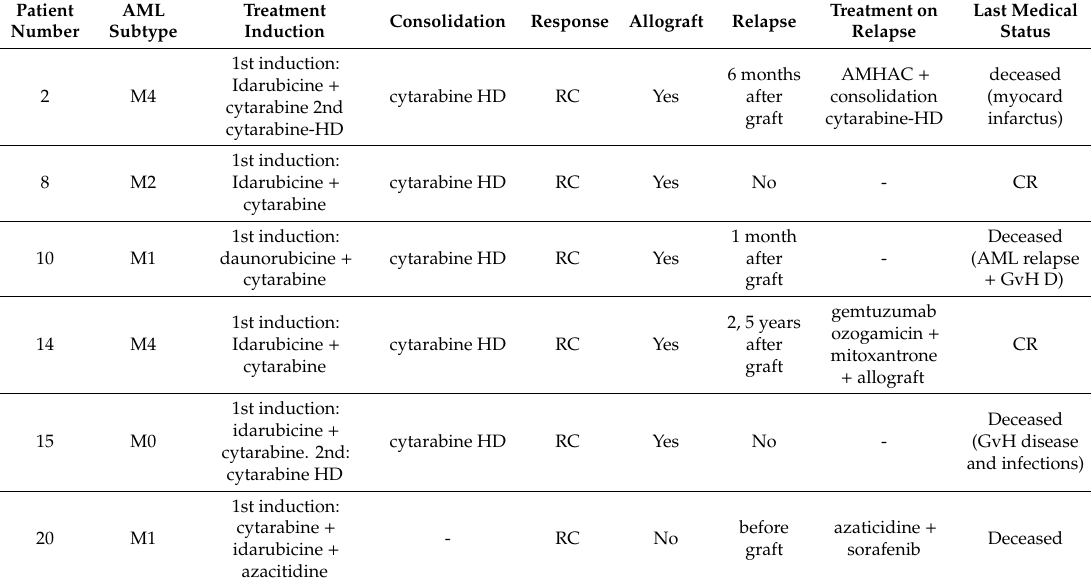
Table 2. Clinical characteristics of the acute myeloid leukemia (AML) cohort. Patients’ subtype according to the French-American-British (FAB) classification, treatment, and outcome of the AML cohort use in this study. Cohort of 6 patients is composed of 5 men (83%) and 1 woman (17%). Patients were between 25 and 59 years old. List of abbreviations: Complete Response to treatment